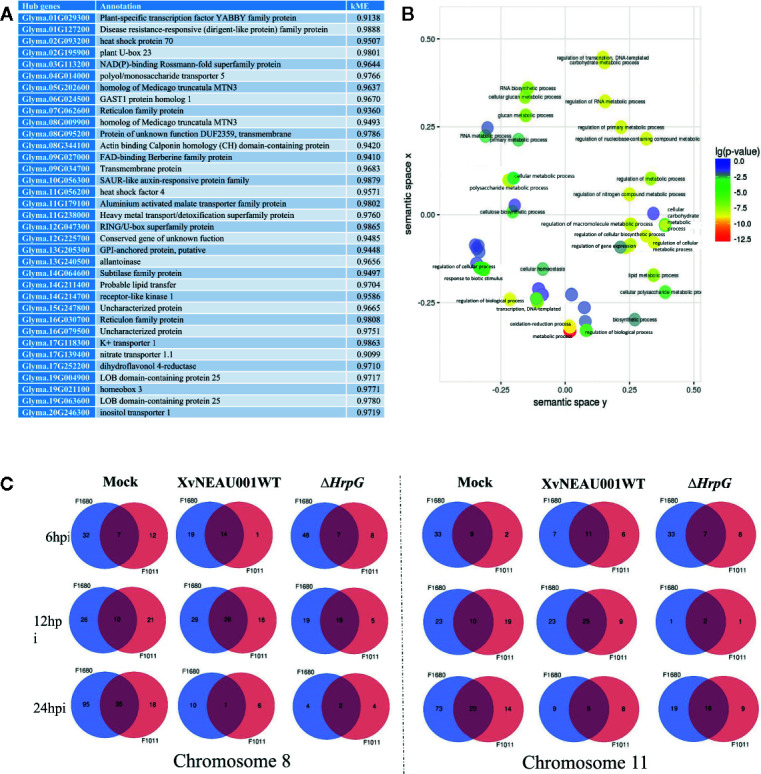
Annotation of genes in significant modules. (A) Annotation of candidate hub genes. (B) GO annotation of hub genes. (C) Two significant hub gene interacting networks in substituted segments of chromosomes 08 and 11.